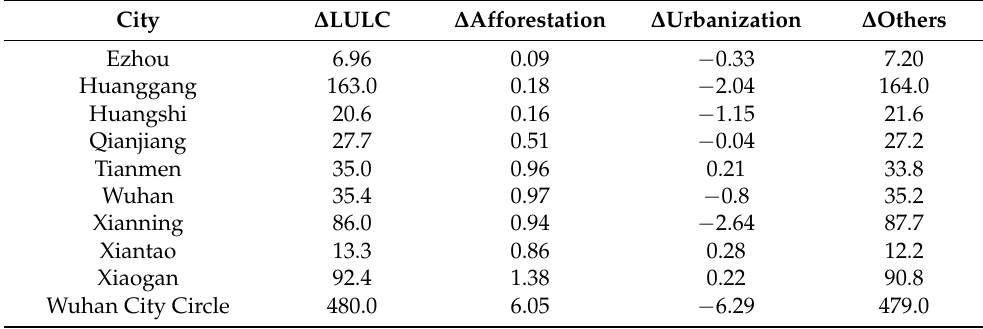
Table 6. The effects of land use changes on total carbon sequestration (10 10 gC) for the Wuhan City Circle area during the period between 2000 and 2015. ∆ LUCC, the effect of all land use changes; ∆ Afforestation, the effect of non-forest land changes on forest land; ∆ Urbanization, the effect of non-construction land changes on construction land; ∆ Others, the effect of other land use changes. City ∆ LULC ∆ Afforestation ∆ Urbanization ∆ Others